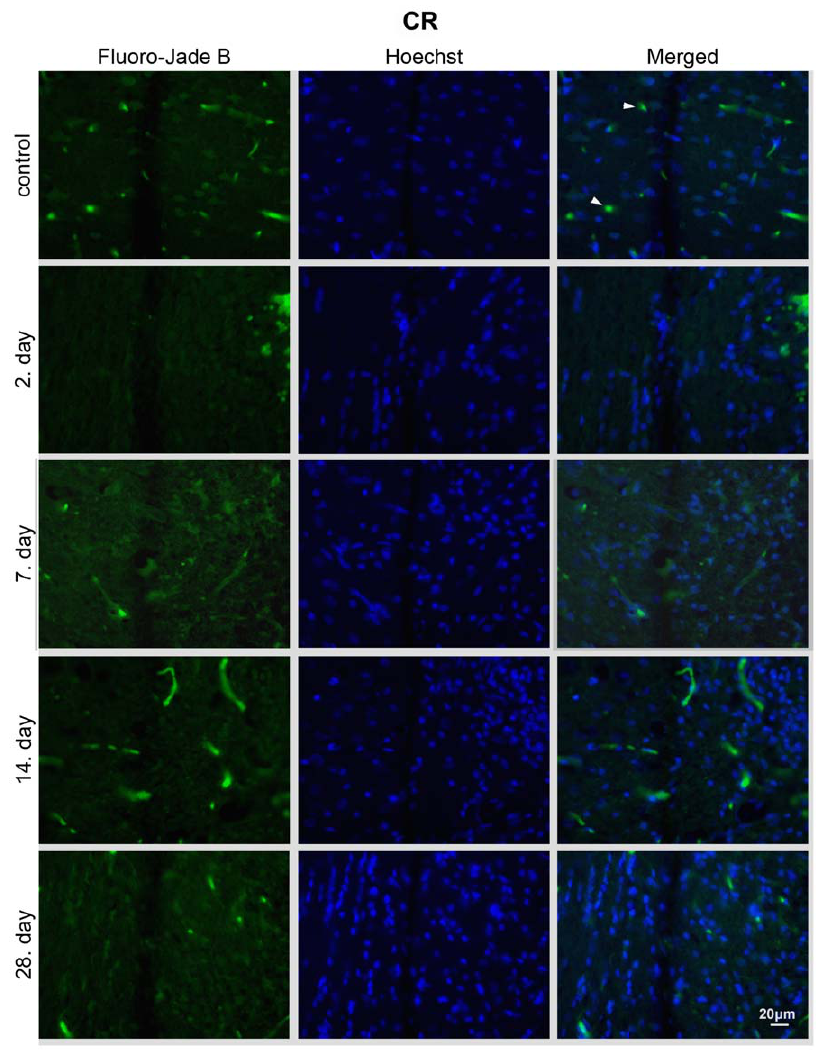
Figure 5. CR treatment suppresses neuroapoptosis in the perilesioned area. Fluoro-Jade B and Hoechst staining of brain sections from CR animals 2, 7, 14, 28 – days after injury. Fluoro-Jade B/Hoechst positive cells were not detected in the CR group at any time point. Images are representative of brain sections at the site of the lesion (n=3 animals per experimental group); c – physiological control; 2, 7, 14, 28 – days after the injury; blood vessels (arrowheads); magnification 40 6